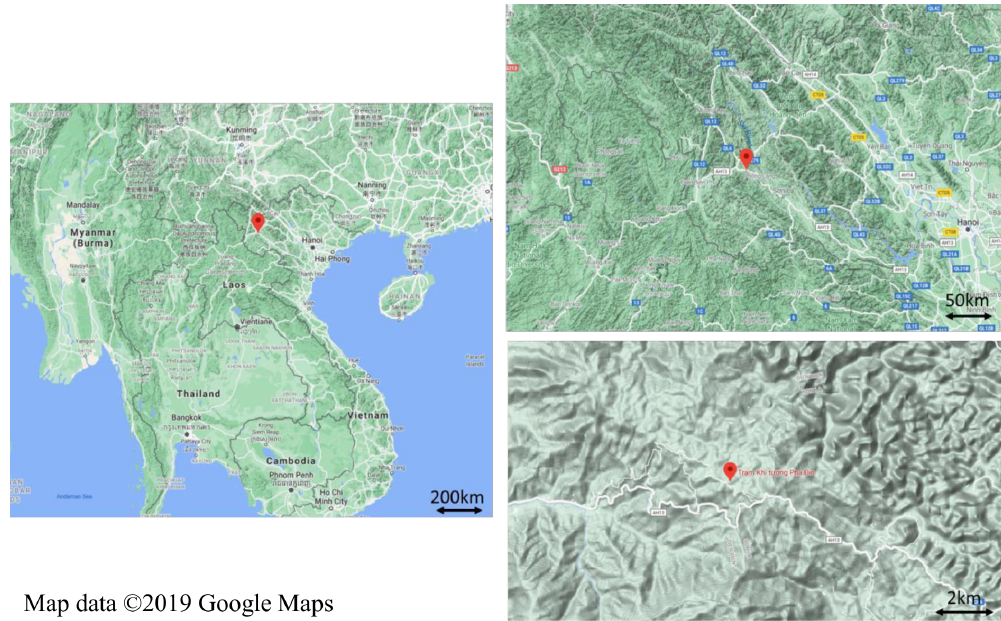
Figure 1. Maps showing PDI monitoring station, Dien Bien Province, Vietnam, in three different scales of 200, 50, and 2km. The maps are retrieved from the © Google Terrain Map